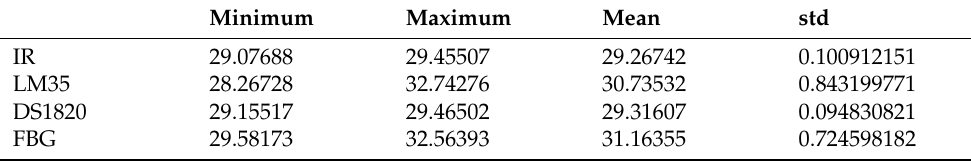
Table 4. Statistics of the measurements of all sensors for discharging the